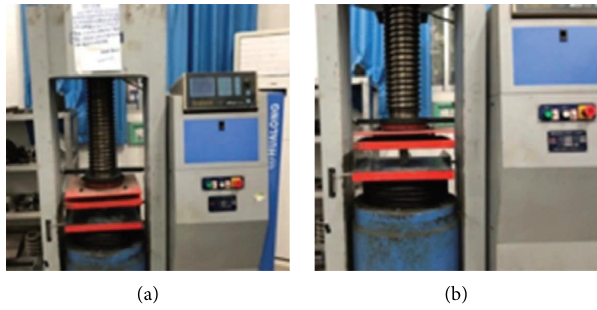
Figure 3: Compressive test of the specimens. (a) Compressive machine. (b) Te compressive test process.